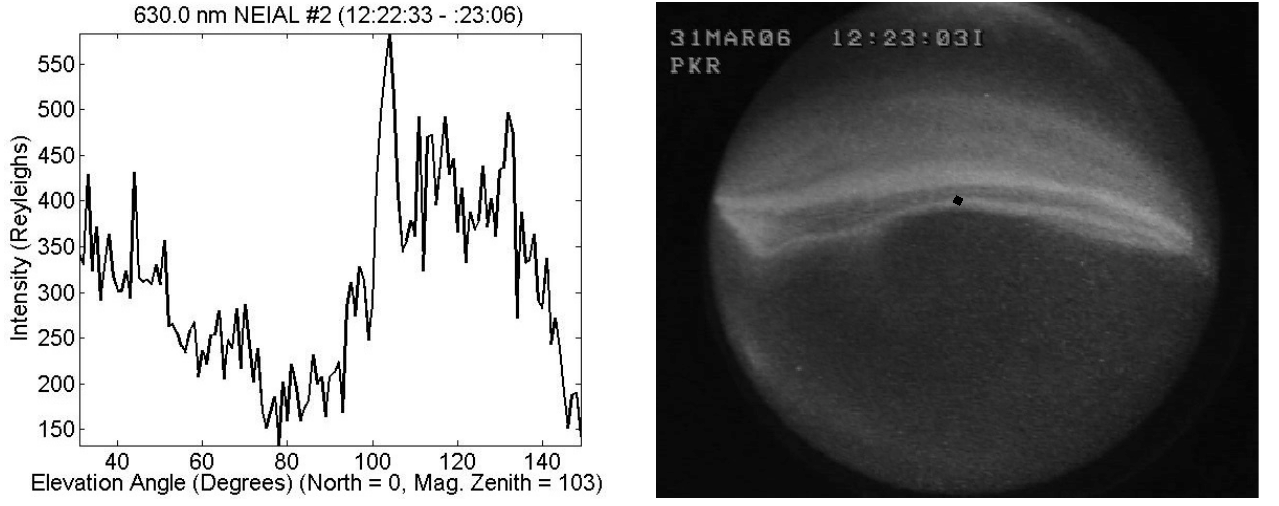
Fig. 6. The mean of three consecutive scans of the 630.0nm channel of the Poker Flat MSP along the magnetic north-south direction at around 12:23UT, which corresponds to the time of NEIAL #2. The magnetic zenith is at 103 ◦ and north is at 0 ◦ .